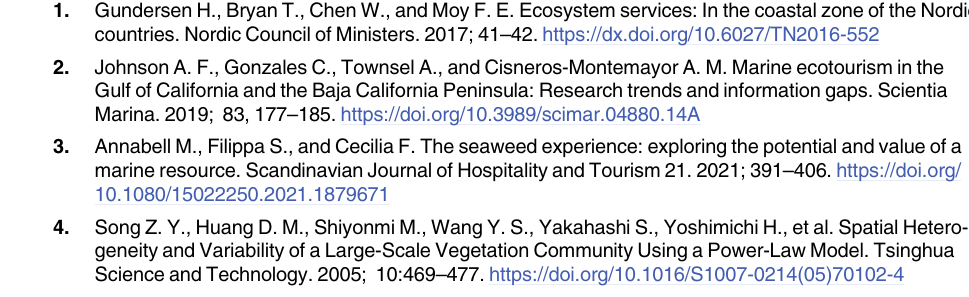
S2 Fig. Distribution types. S3 Fig. Statistical results. S4 Fig. Spatial heterogeneity index. S5 Fig.